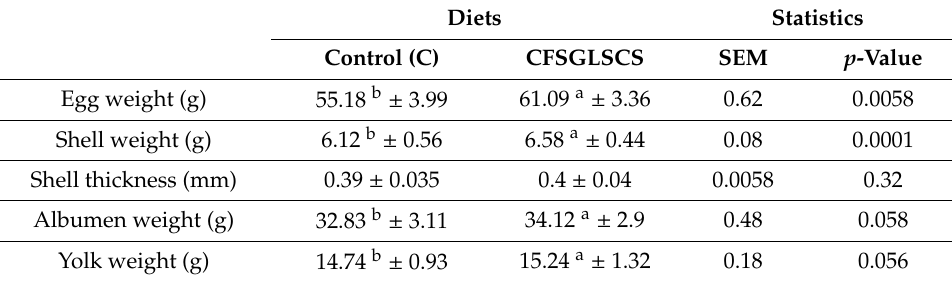
Table 3. E ff ects of various diets on egg